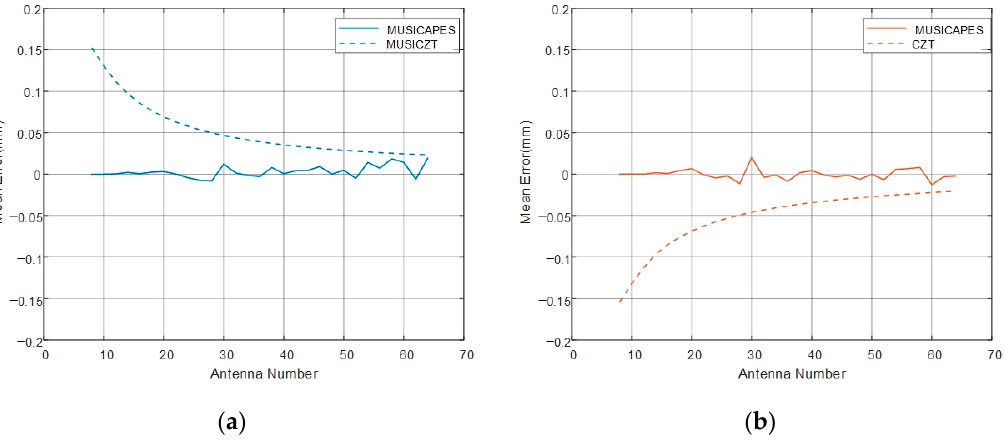
Figure 9. Mean error of displacement difference vs. array length. ( a ) The mean error of ‘Target1’; ( b ) the mean error of ‘Target2’.